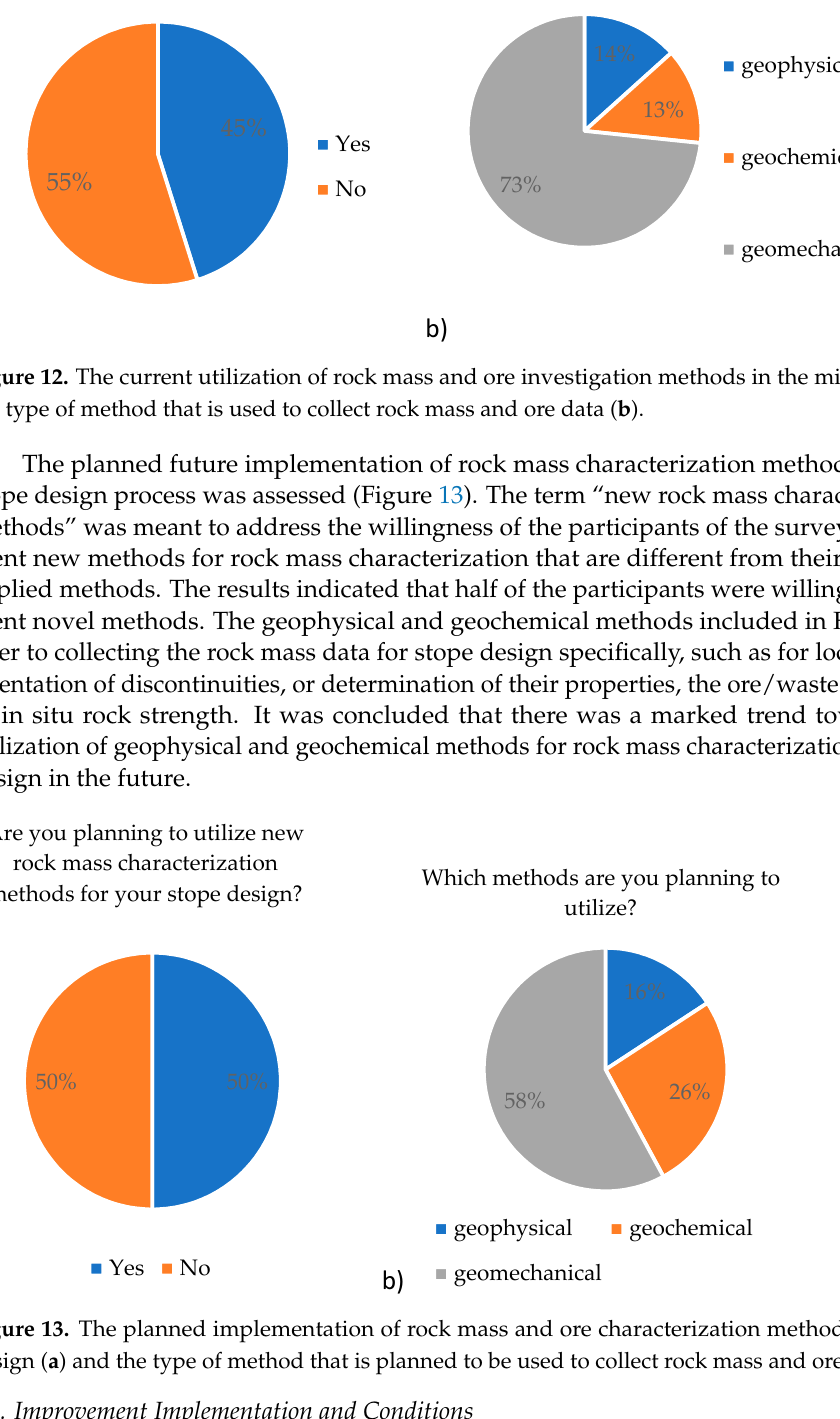
Figure 13. The planned implementation of rock mass and ore characterization methods for stope design ( a ) and the type of method that is planned to be used to collect rock mass and ore data ( b ).